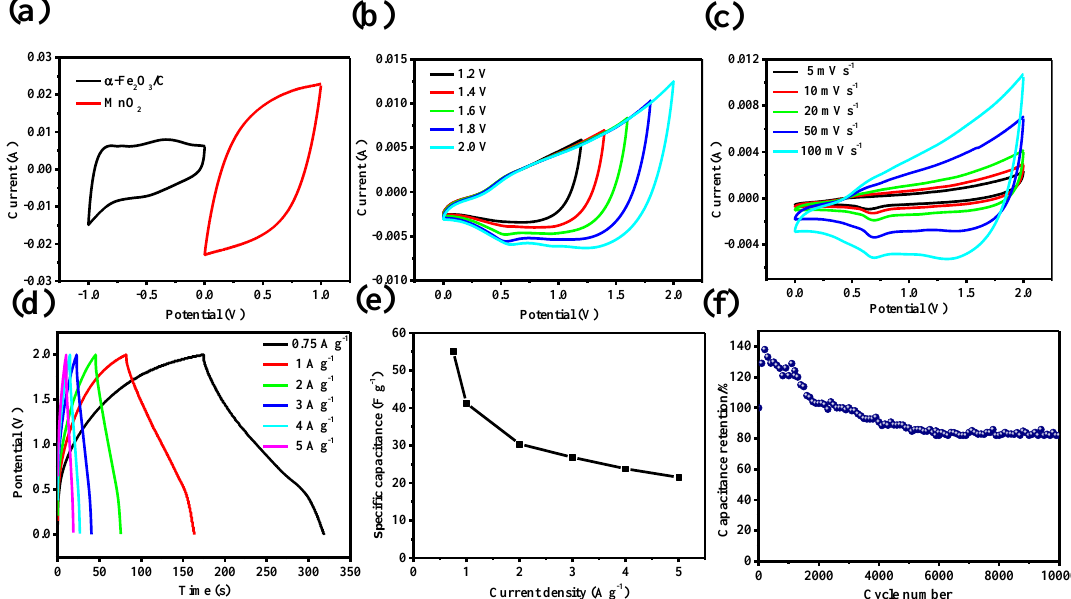
Figure 4. ( a ) CV curves of α-Fe 2 O 3 @C nanowire electrode and MnO 2 nanosheets electrode at a scan rate of 100 mV s −1 ( b ) CV curves of ASC in different potential windows ( c ) CV curves of ASC at different scan rates in a voltage range between 0 and 2 V ( d ) GCD curves of ASC device at different current densities ( e ) The specific capacitance of the ASC device calculated from GCD curves ( f ) Cycle performance of ASC.